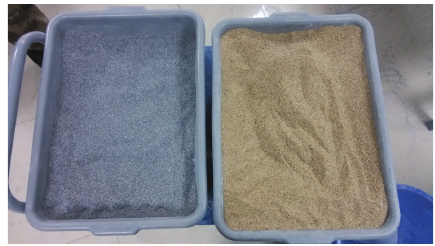
Figure 1: Raw material: barite sand and quartz